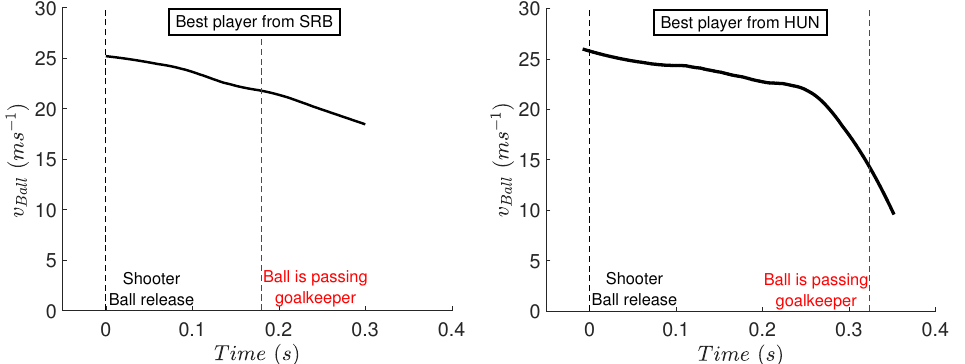
Figure 6. Exemplary temporal ball speed (at time t3, leaving the hand) at goal completion using drive shot.